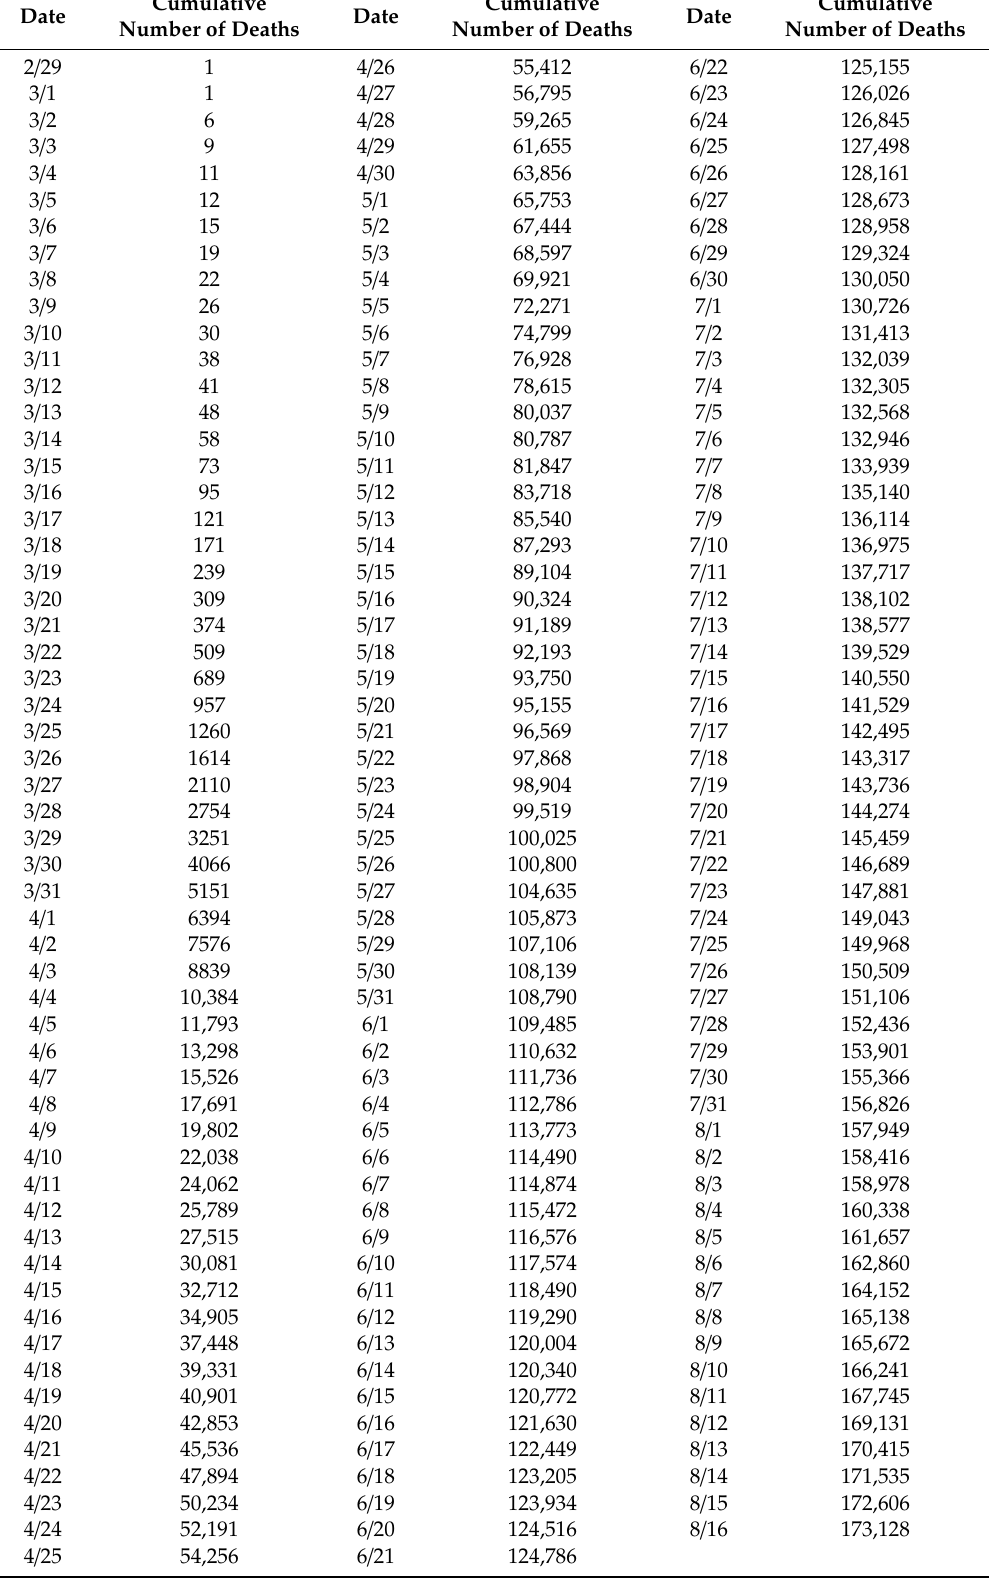
Table A1. U.S. death data [5] from 29 February 2020 to 16 August